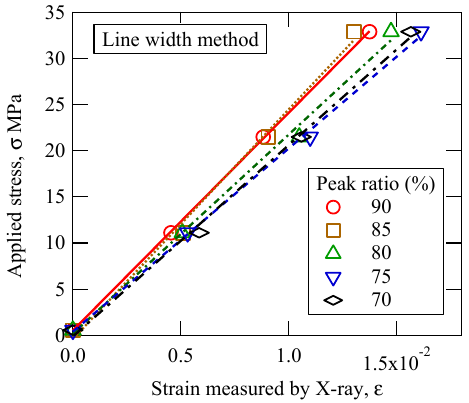
Figure 7. Relation between applied stress and strain measured by X-ray for line width method.